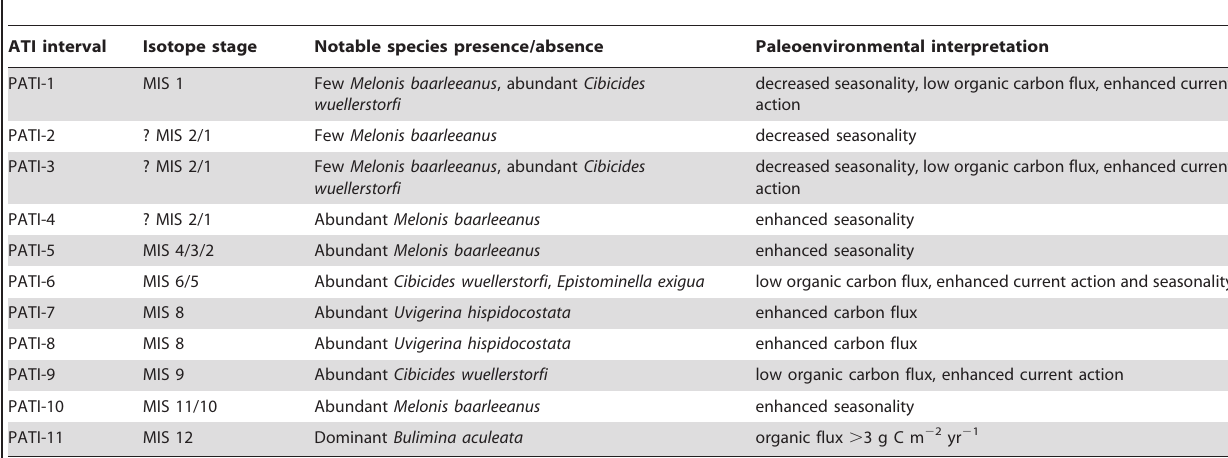
Table 3. Environmental interpretation of peak-bounded ATI s (PATI-) intervals in the Upper Quaternary in ODP Hole 994C, Blake